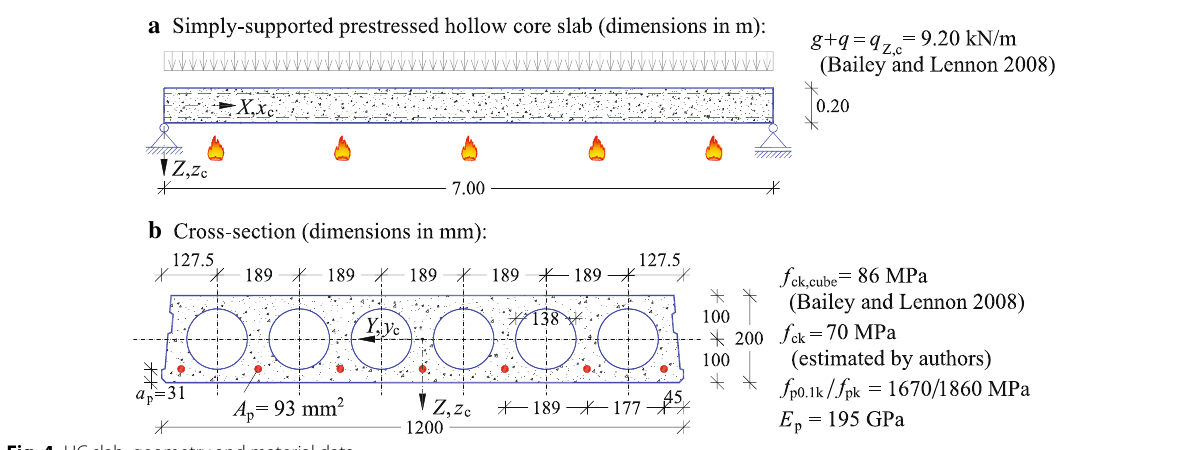
Fig. 4 HC slab: geometry and material data.